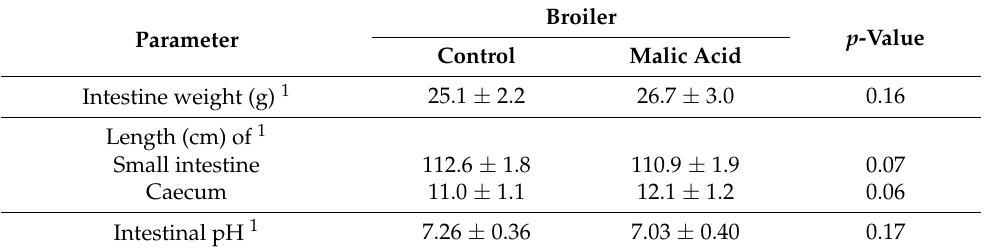
Table 2. Intestinal weight, length, and pH of broilers receiving malic acid-supplemented drinking water at slaughter